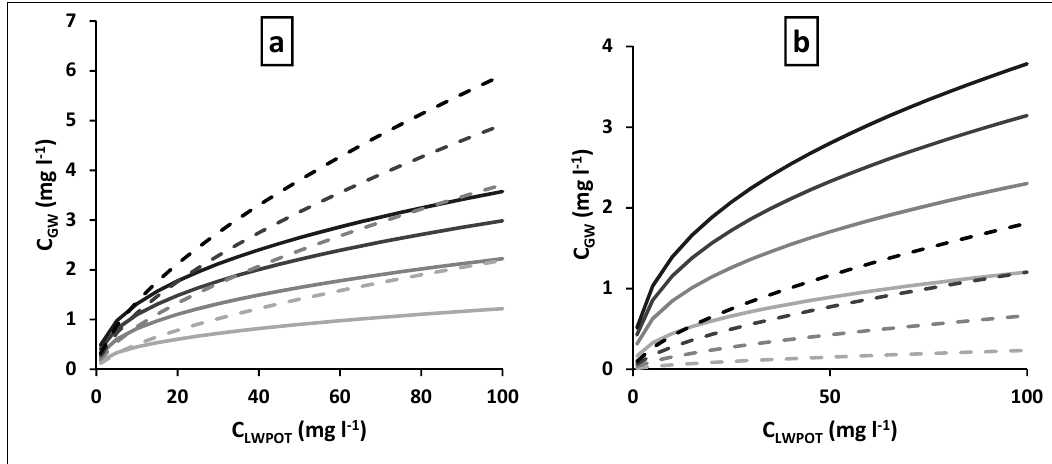
Figure 8. Groundwater nitrogen concentration vs. potential leachate concentration and their dependency of annual recharge using old and new retention parameters. ( a ) Consolidated rocks with high porosity; ( b ) unconsolidated rock with shallow groundwater. Dashed line: original parameters; continuous: adjusted parameters. Recharge values 10, 20, 30, 40 mm y − 1 from lighter to darker colors.